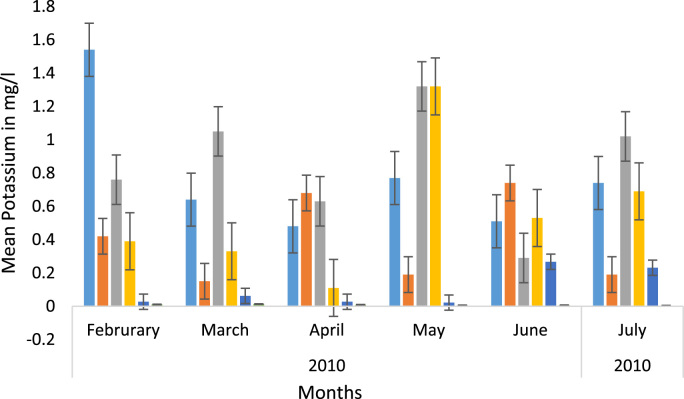
Mean Temporal and spatial variations in potassium.